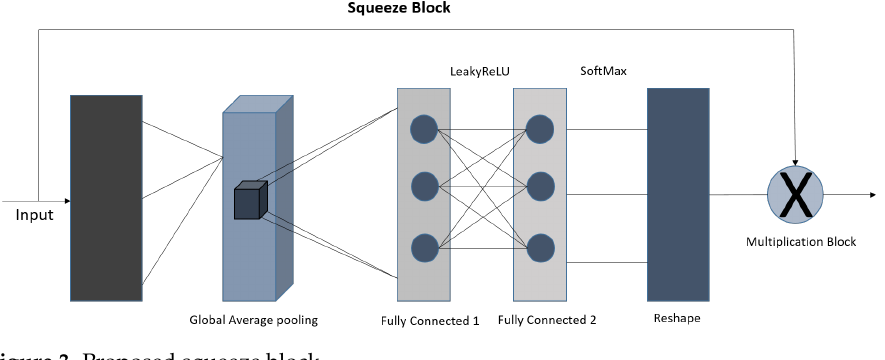
Figure 3. Proposed squeeze